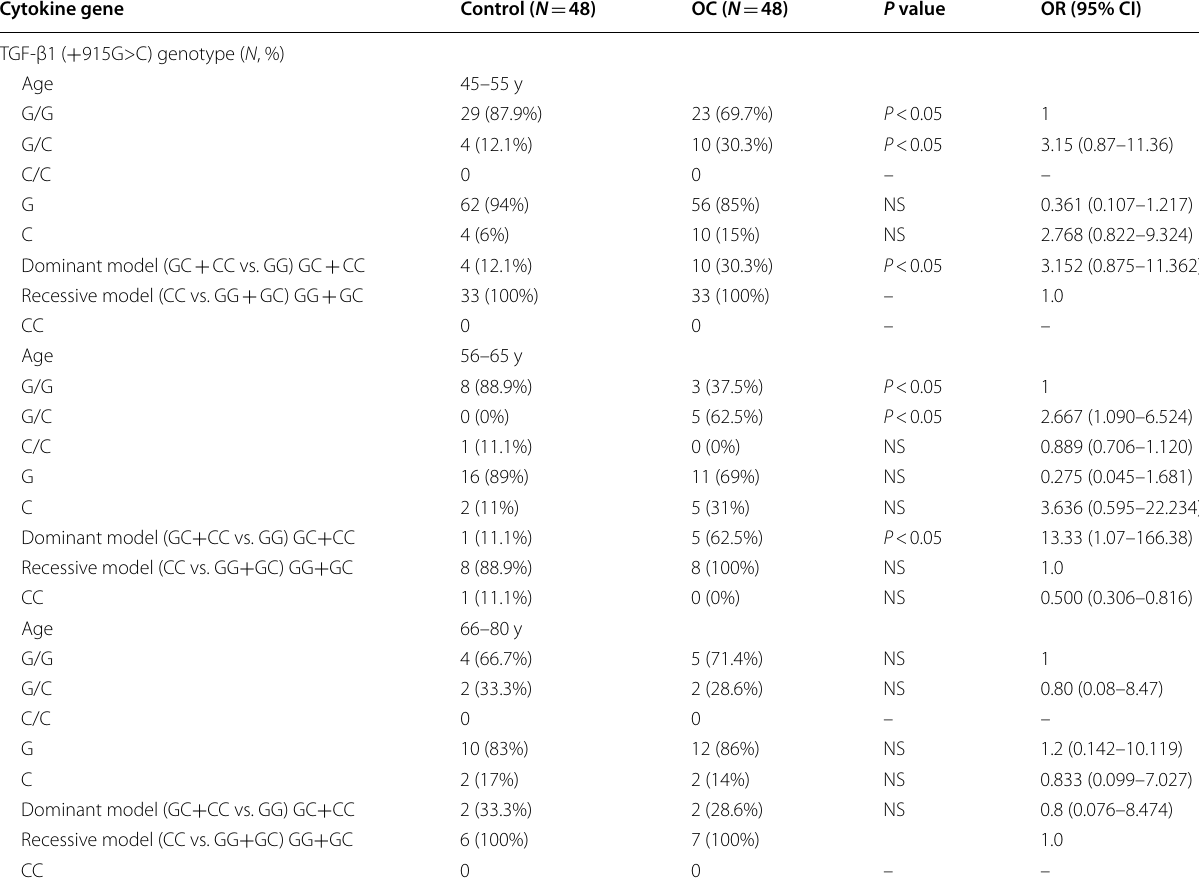
Table 7 Genotype distribution and allelic frequency of TGF‑β1 ( ages